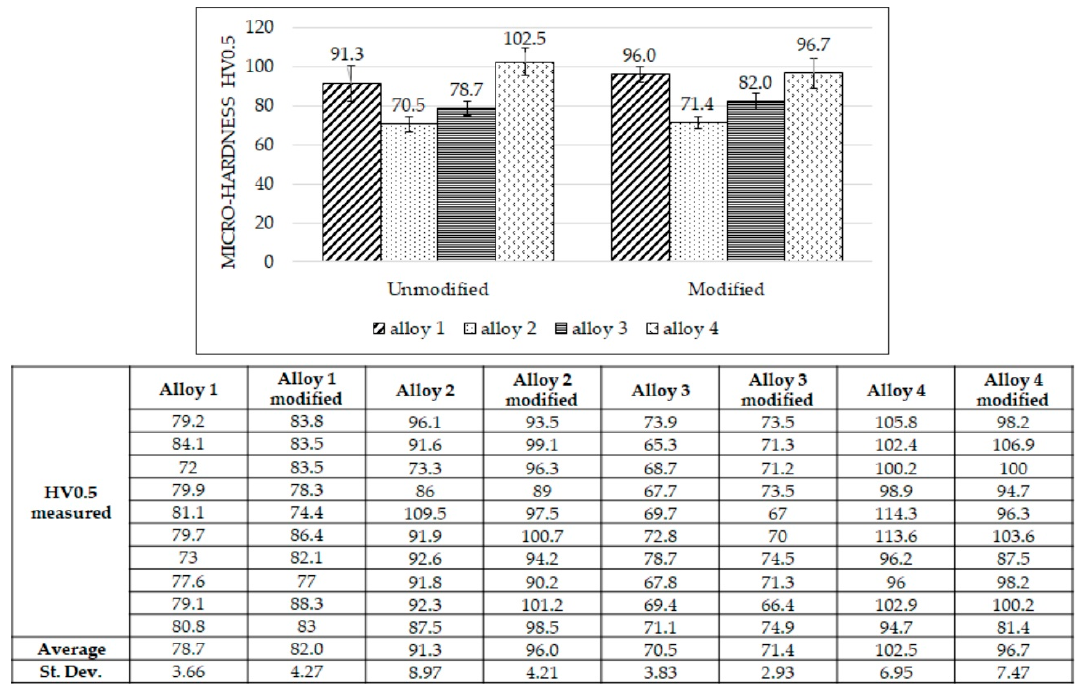
Figure 3. Micro-hardness measurements for all the alloys, unmodified (left side) and modified (right side). Values reported are average values. The table reports all micro-hardness measurements. Alloy 1: 86-93 HV0.5 = α -Al; from 93 to 100 HV0.5 = eutectic; up to 100 HV0.5 = intermetallic phases. Alloy 2: 65–70 HV0.5 = α -Al; up to 70 HV0.5 = eutectic. Alloy 3: 70–80 HV0.5 = α -Al; from 80 to 83 HV0.5 = eutectic silicon; up to 83 HV0.5 = intermetallic phases. Alloy 4: 96–100 HV0.5 = α -Al; from 100 to 110 HV0.5 = eutectic silicon; up to 110 HV0.5 = intermetallic phases.